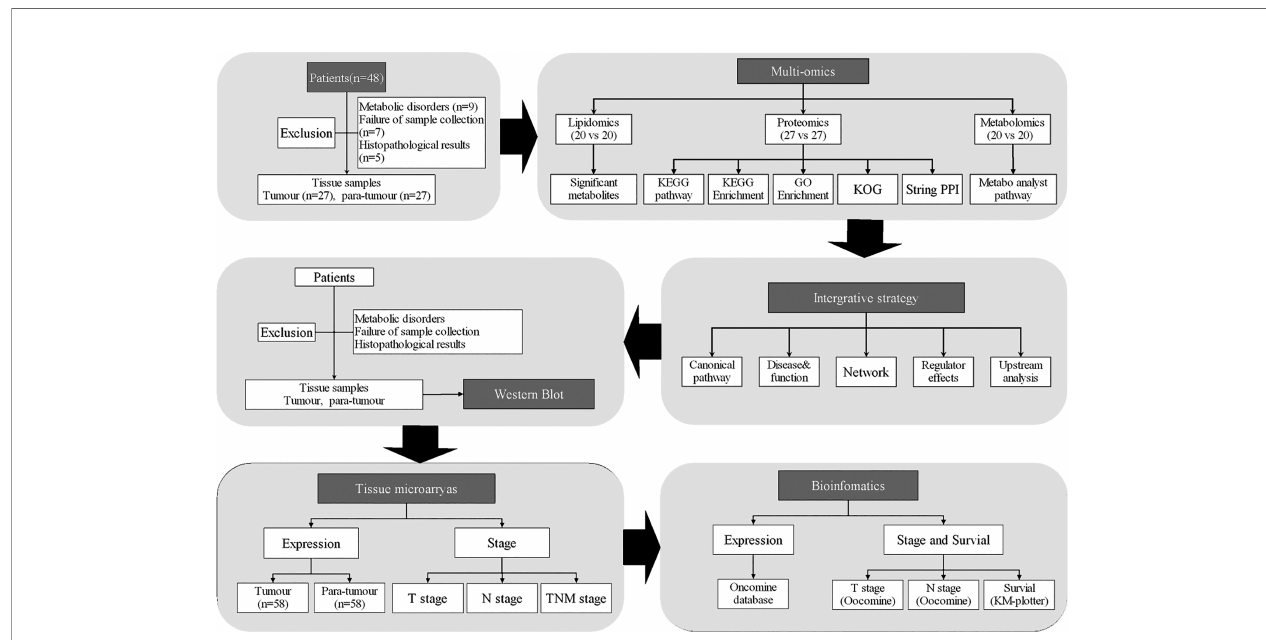
FIGURE 1 | Flow chart of the